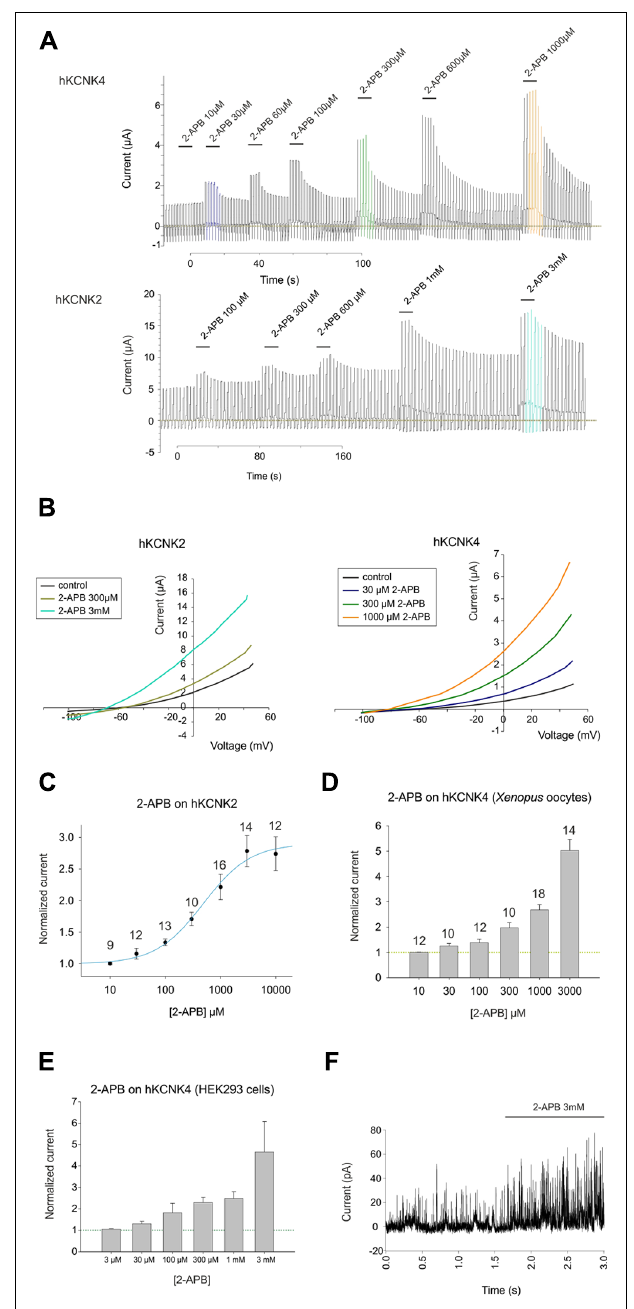
FIGURE 2 | (A) Representative traces showing the effect of increasing concentrations of 2-APB on hKCNK4-expressing (top) and hKCNK2-expressing (bottom) Xenopus oocytes subjected to the ramp series protocol described in the experimental procedures. (B) Representative I–V traces for the excitatory effect of increasing concentrations of 2-APB on oocytes expressing hKCNK2 (left) and hKCNK4 (right). (C) Dose–response curve showing the effects of 2-APB on hKCNK2 and fitted to the 4-parameter Hill equation ( n indicated above the points). (D) Dose–response relationship showing the effect of 2-APB on hKCNK4 ( n indicated above the points). (E) Dose–response relationship showing the effect of 2-APB on hKCNK4 ( n = 3–5 HEK293 cells). (F) Inside-out patch-clamp recordings of cell-excised patches from hKCNK4-expressing HEK293 cells before and after exposure to 3 mM